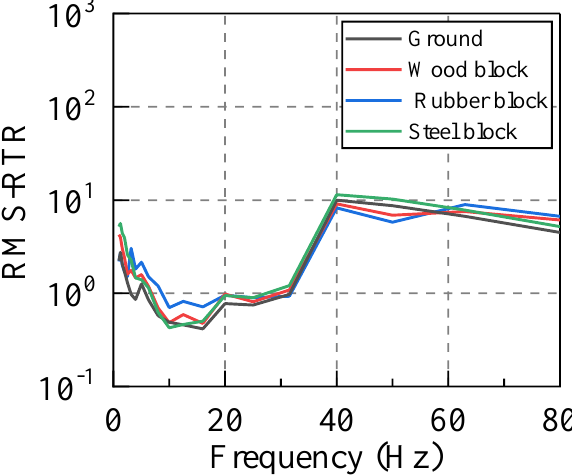
Figure 10. RMS − RTR. (Different cushion blocks)